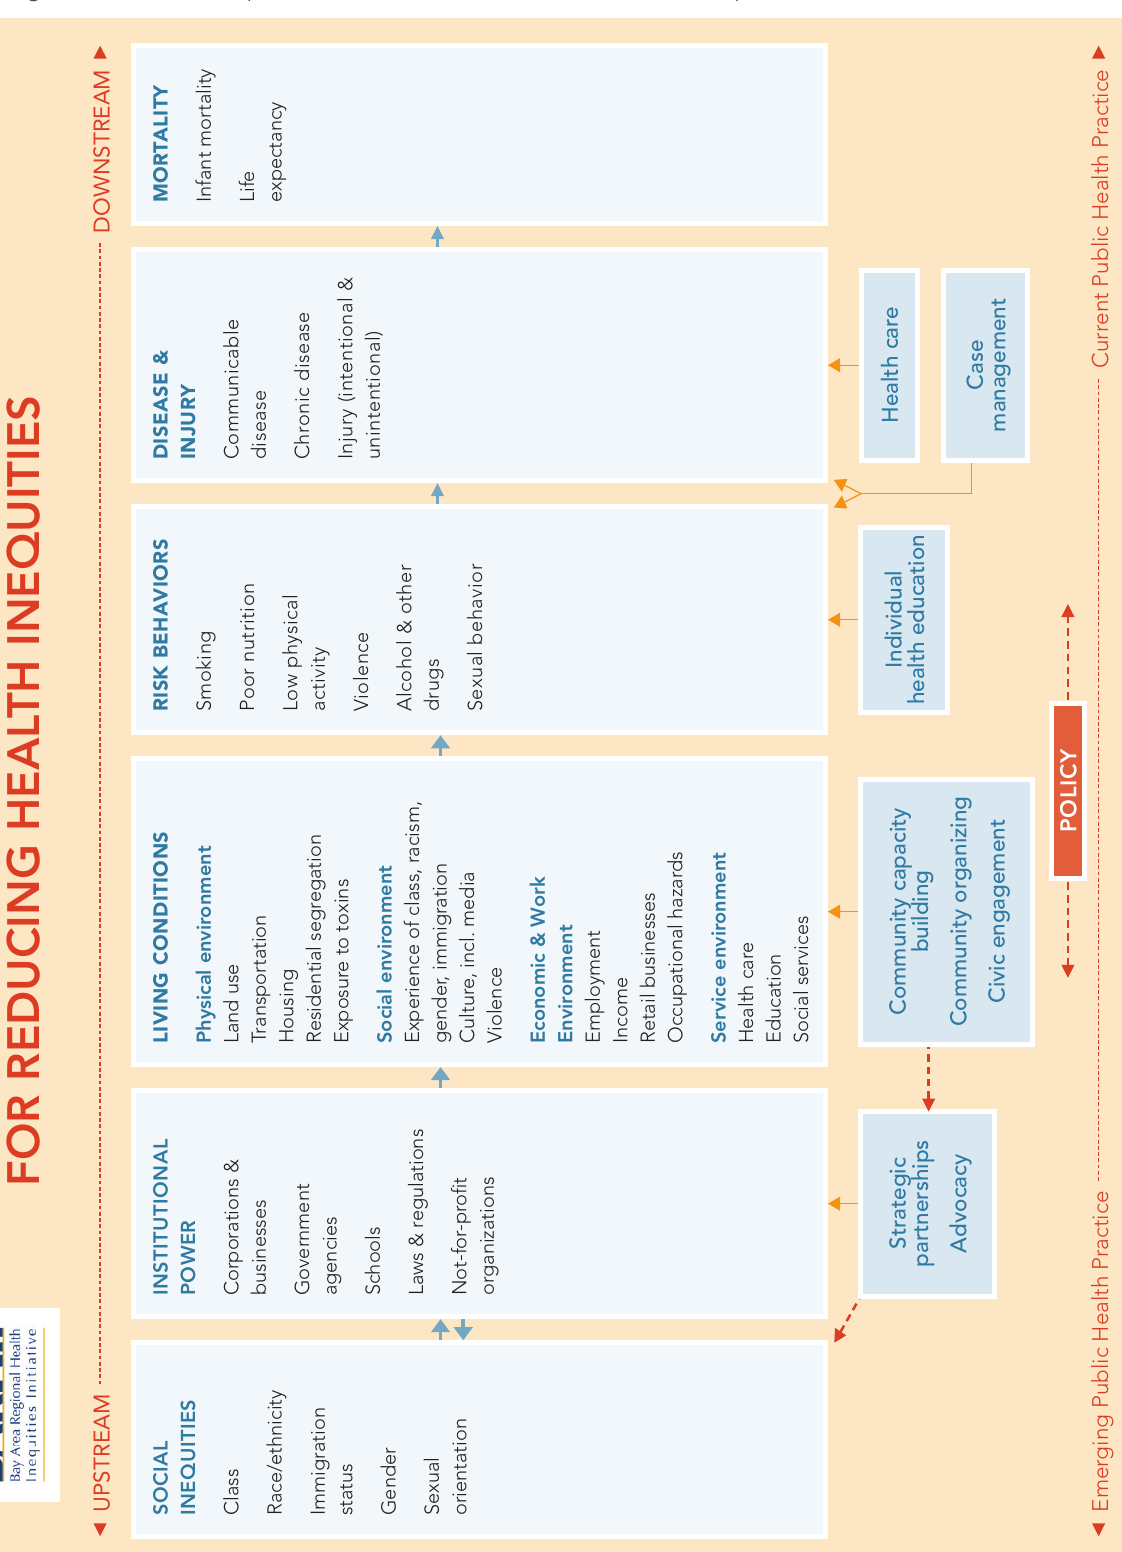
FIGURE 2. A PUBLIC HEALTH FRAMEWORK FOR REDUCING HEALTH INEQUITIES Bay Area Regional Health Inequities Initiative. (2010, June). Used with